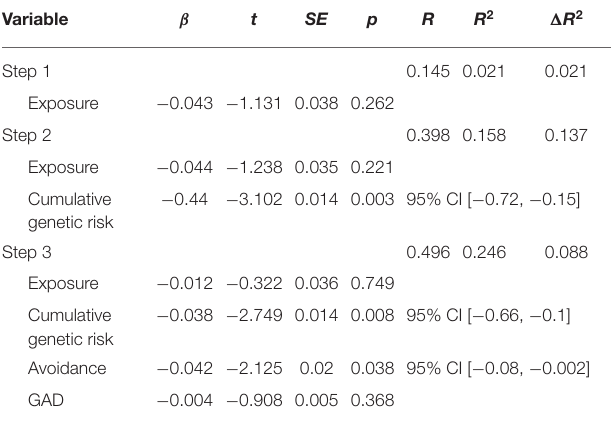
TABLE 4 | Summary of hierarchical regression analysis for variables predicting PLV.